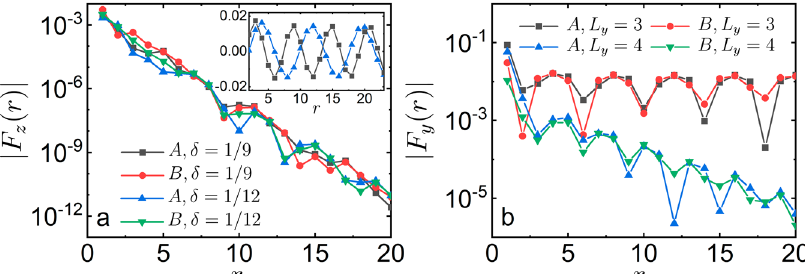
Fig. 4 Spin – spin correlations. a F z ( r ) for three-leg cylinder at different doping levels δ and b F y ( r ) for both three and four-leg cylinders at doping level δ = 1/12. Inset shows the SDW spatial oscillation, i.e., F y ( r ), with the black square and blue triangle symbols are for δ = 1/9 and δ = 1/12, respectively.